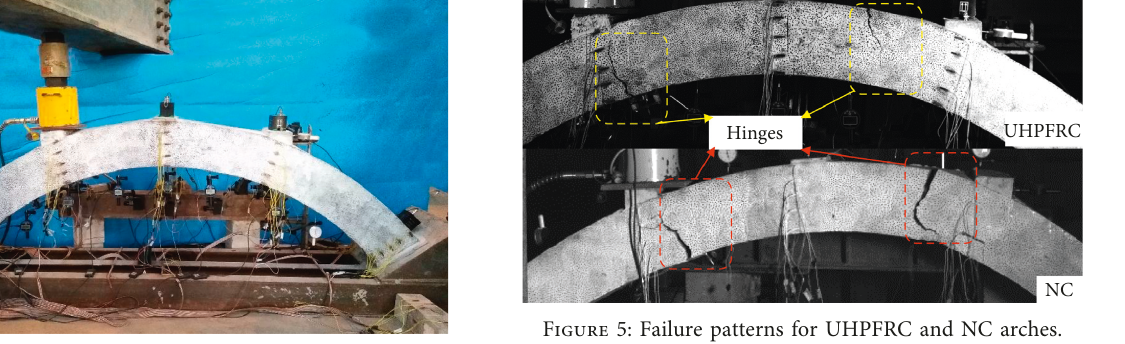
Figure 4: Test scheme and instrumentation of the arch test.